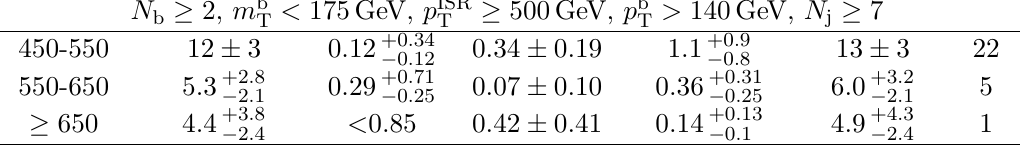
Table 5 . Predicted background yields and the observation in di(cid:11)erent search regions for the